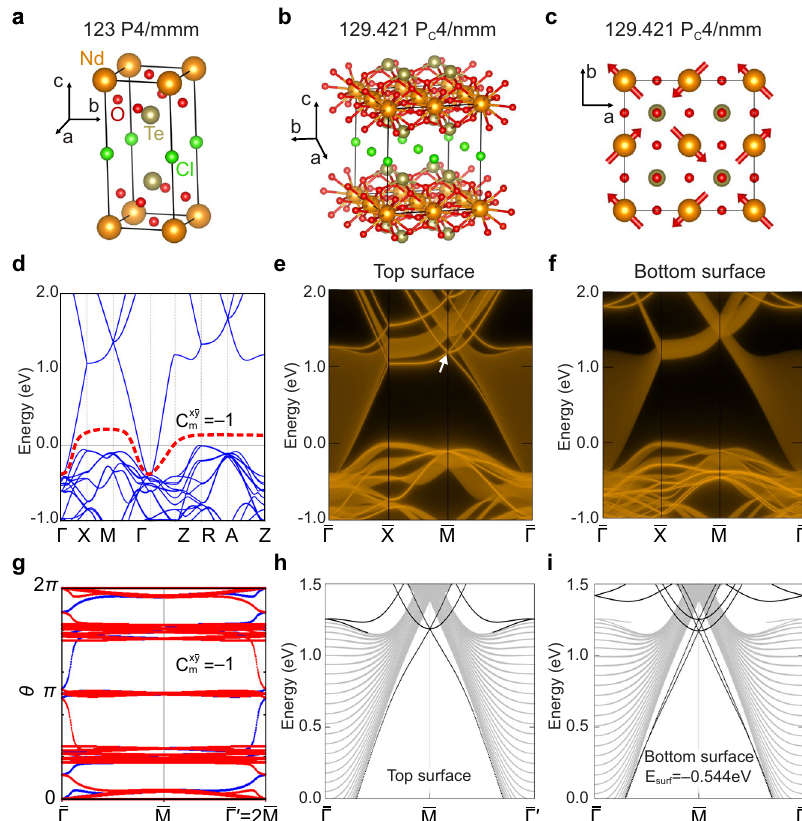
Fig. 4 Nd 4 Te 8 Cl 4 O 20 , a Type-IV TMDI candidate. a , b Crystal structures of NdTe 2 ClO 5 and Nd 4 Te 8 Cl 4 O 20 (2 × 2 × 1 supercell). c Magnetic 4 mm . d Bulk band structure from DFT + U calculations structure compatible with Type-IV MSG 129.421 P C 4/ nmm and (001)-surface MWG p 0 c ( U = 6 eV). The band gap near the Fermi level is indicated by the red dashed line. e , f (001)-surface spectra for the e top (O-terminated) and f bottom (Nd-terminated) surfaces obtained using the surface Green ’ s function method. The surface Dirac fermion is indicated by the white 1 . h – i (001)-surface for arrow in e . g k z -directed Wilson loop spectrum along the diagonal path Γ - M - Γ 0 . The winding structure exhibits C xy m ¼ (cid:4) the h top and i bottom surfaces from a 30-layer slab calculation. Bulk and surface bands are represented by gray and black, respectively. The fourfold-degenerate Dirac fermions are located approximately 1 eV from the Fermi level on the top surface. A surface potential of − 0.544 eV is introduced to push the Dirac point on the bottom surface into the